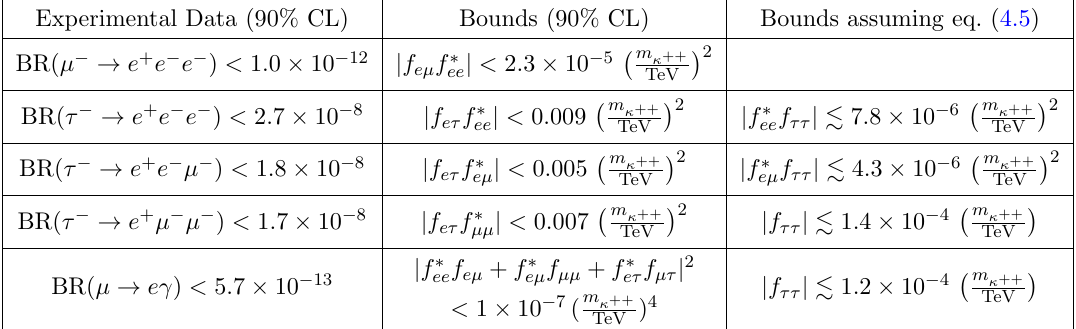
Table 1 . Relevant constraints for our model from LFV decays [44, 45]. Limits on the Yukawa couplings of the doubly charged singlet scalars have been taken from ref. [46]. The constraints in the third column are obtained from those in the second column assuming eq. (4.5) holds.